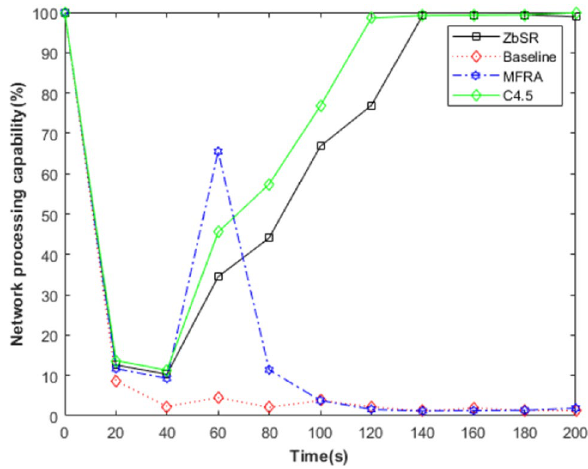
Figure 14. Comparison of the decline of the processing capacity of 4 models.